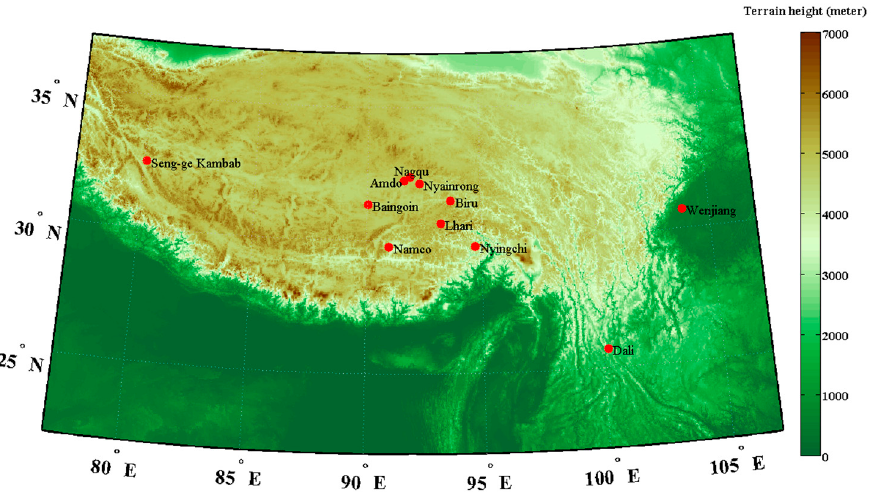
Figure 1. Topography of the Tibetan Plateau, with 9 plateau stations denoted by red dots. It should be noted that the Nyingchi and Namco stations were excluded from our study after the data quality control steps were completed. Table 1. Geographical location information of the seven observation sites on the Qinghai-Tibet Plateau.